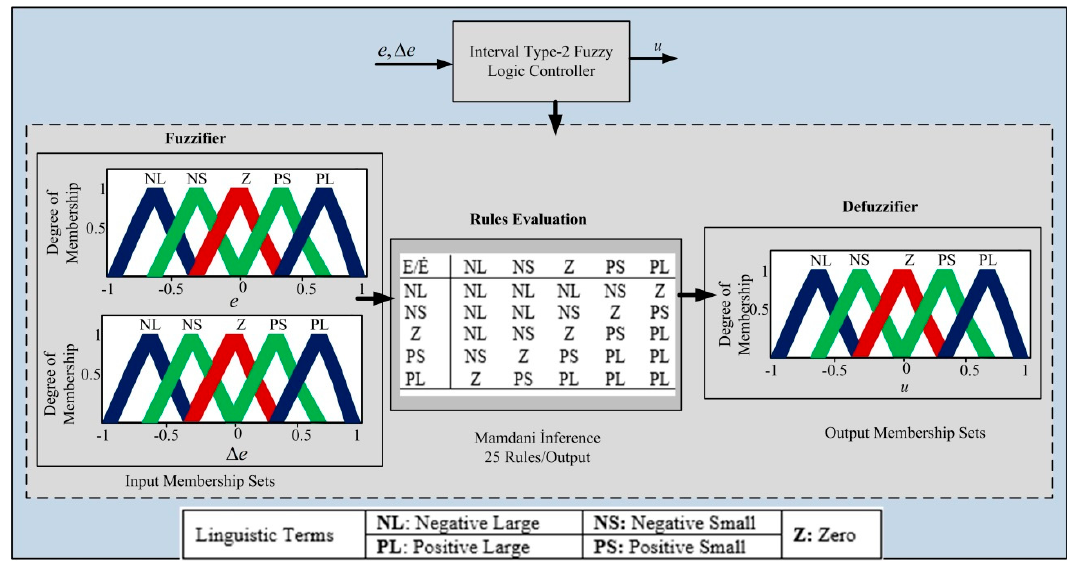
Figure 4. Proposed structure of the interval type 2 fuzzy logic control (IT-2 FLC) system.